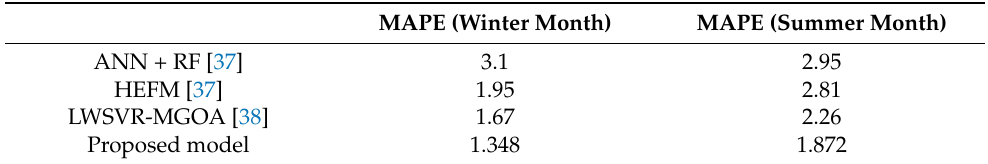
Table 4. Comparison to the existing methods—MAPE for load in the winter months and summer months of the ISO-NE dataset.